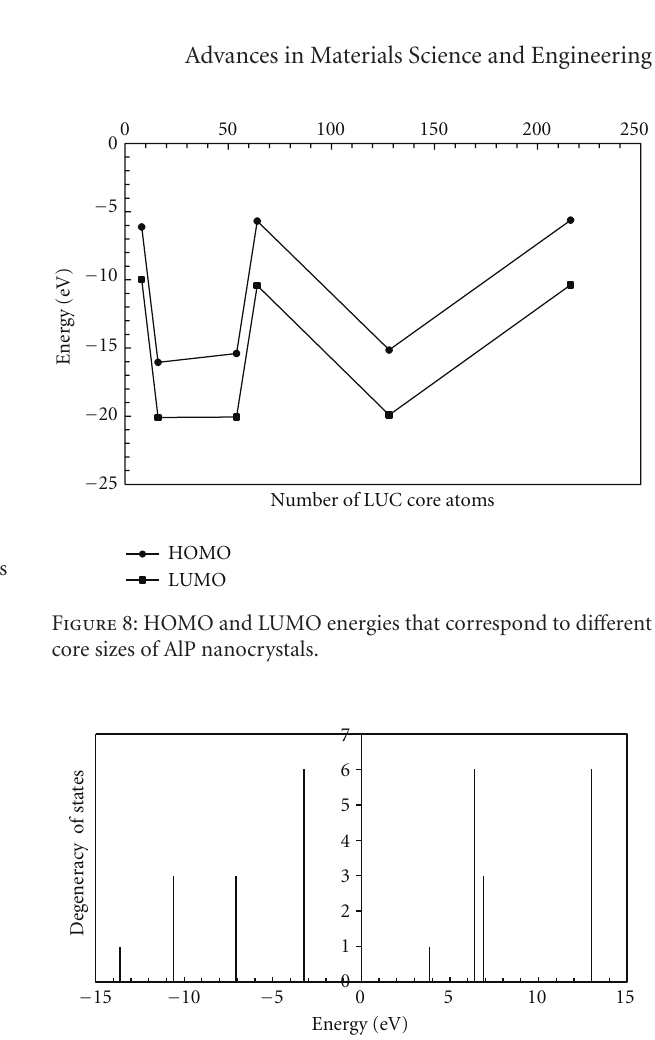
Figure 9: Degeneracy of states of 8-atom core part of zb-AlP nanocrystal as a function of level energy. The HOMO level is taken as the reference